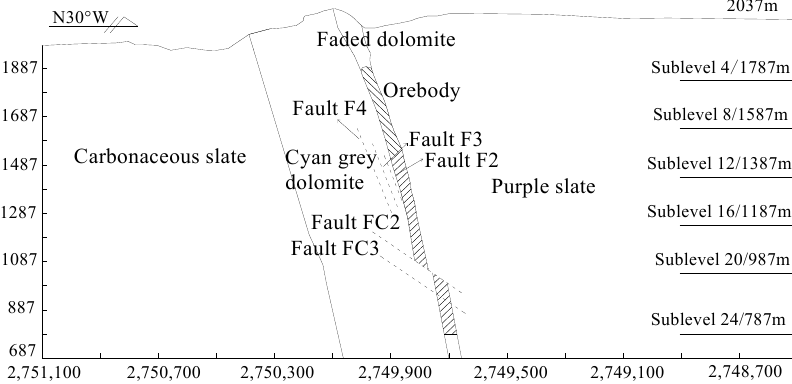
Figure 2. Engineering geological profiles of faults in Shizishan Copper Mine.